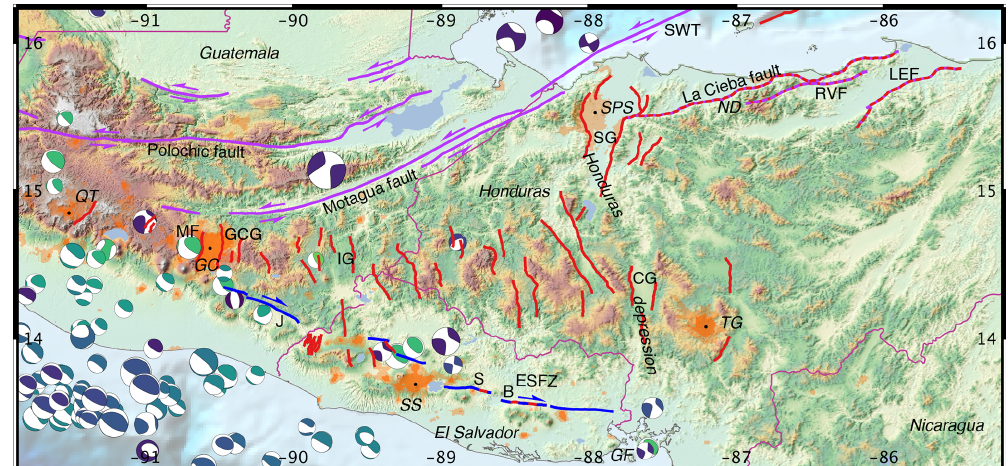
Figure 4. Active faults in the Central Highlands. SWT is the Swan Islands transform. LEF is the La Esperanza fault. RVF is the Río Viejo fault. SG is the Sula graben. IG is the Ipala graben. GCG is the Guatemala City graben. MF is the Mixco fault. CG is the Comayagua graben. J is the Jalpatagua fault. ESFZ is the El Salvador fault zone. S is the San Vicente segment (ESFZ). B is the Berlin segment (ESFZ). ND is the Nombre de Dios range. SPS is San Pedro Sula. GF is the Gulf of Fonseca. SS is San Salvador. GC is Guatemala City. QT is